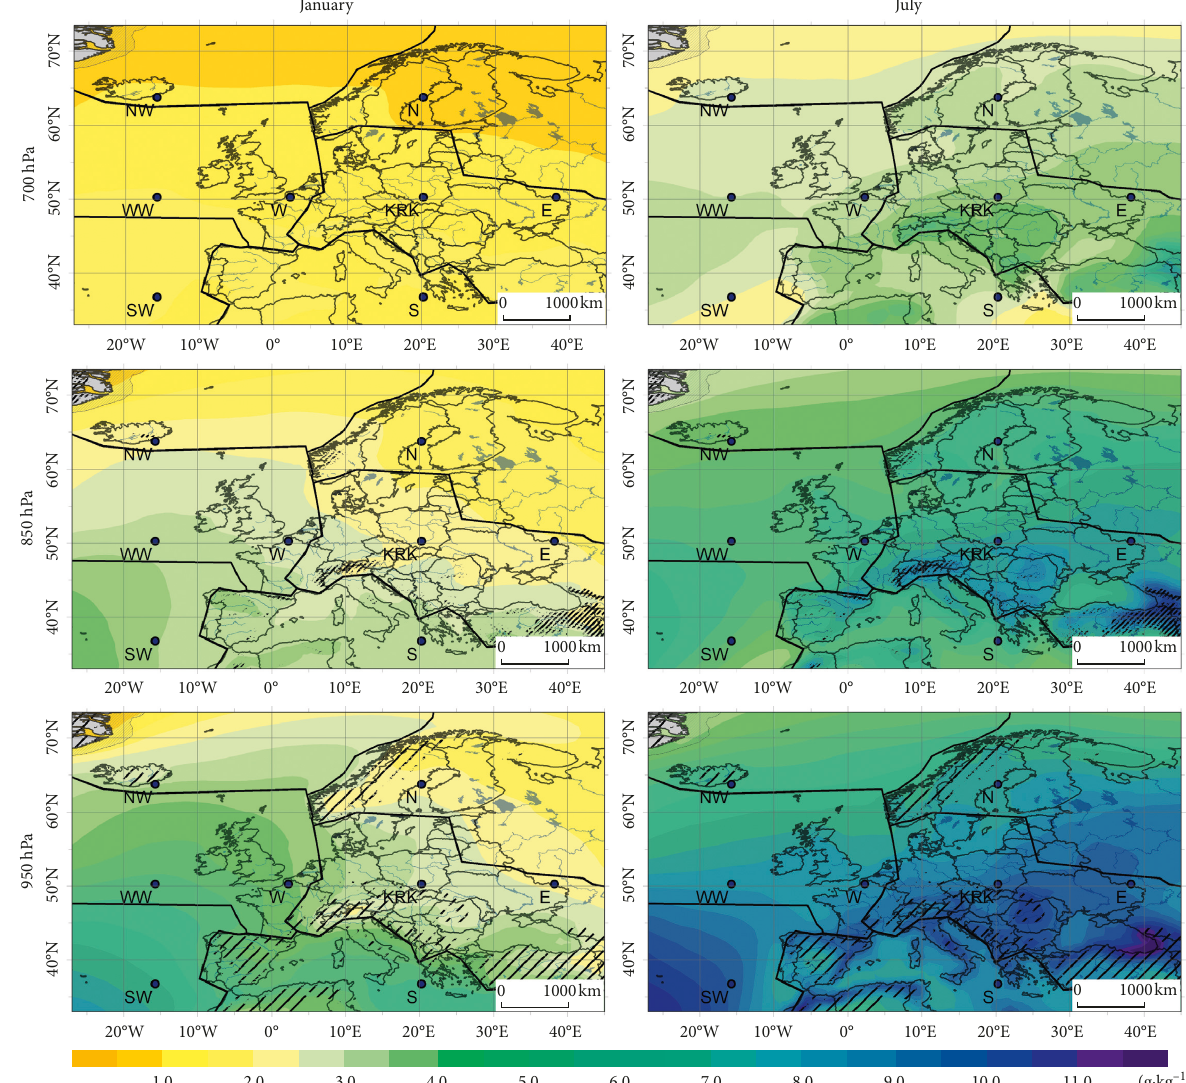
Figure 2: Monthly mean specific humidity at selected pressure levels (1981–2015); slanted lines are used to denote areas situated above the average of selected pressure